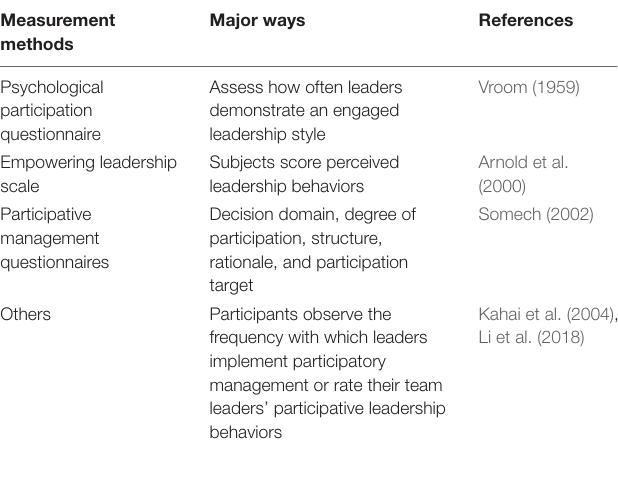
TABLE 1 | Summary of